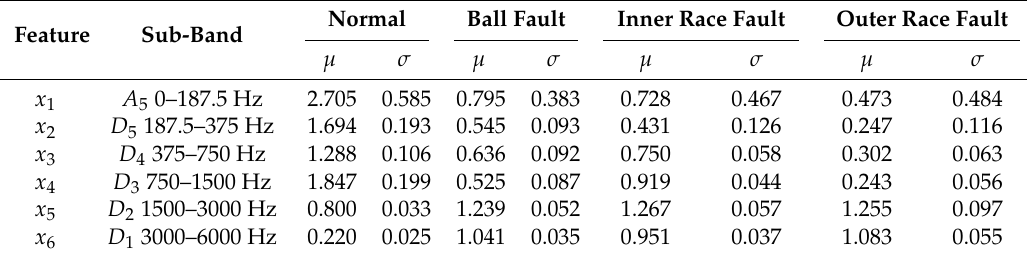
Table 1. Standard deviations of the wavelet coefficients in six sub-bands of interest.